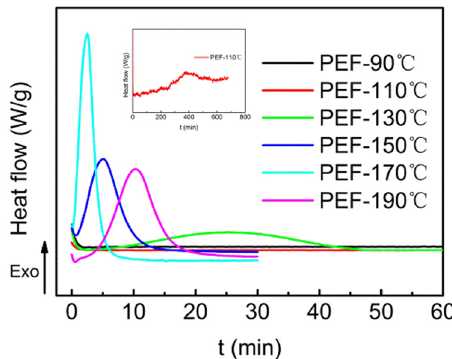
Figure 7: DSC isothermal crystallization curves at di ff erent crystal - lization